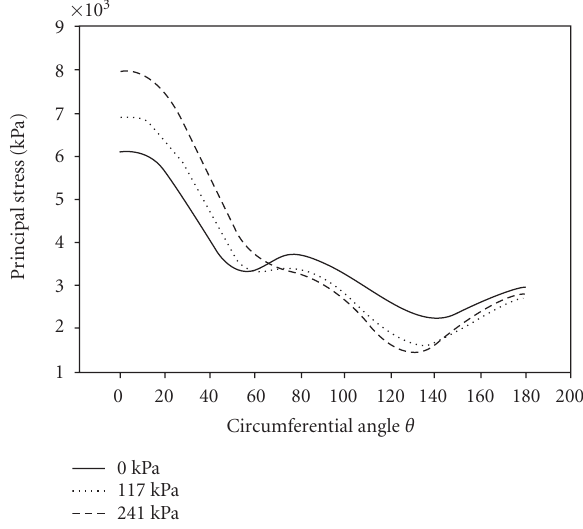
Figure 12: Influence of inflation pressure on the development of the maximum principal stress in the area of the